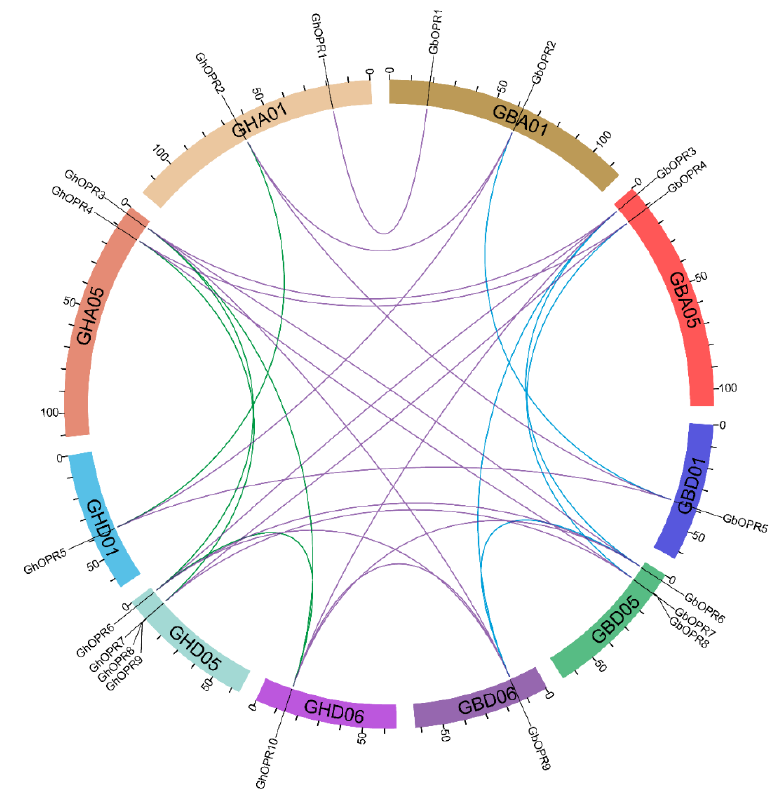
Figure 3. The synteny relationship of OPR genes between G. hirsutum and G. barbadense . Five upland cotton and five sea-island cotton chromosomes are displayed with different random colors. Lines in purple represent orthologous gene pairs, green represent upland cotton paralogous gene pairs, and blue represent sea-island paralogous gene pairs.